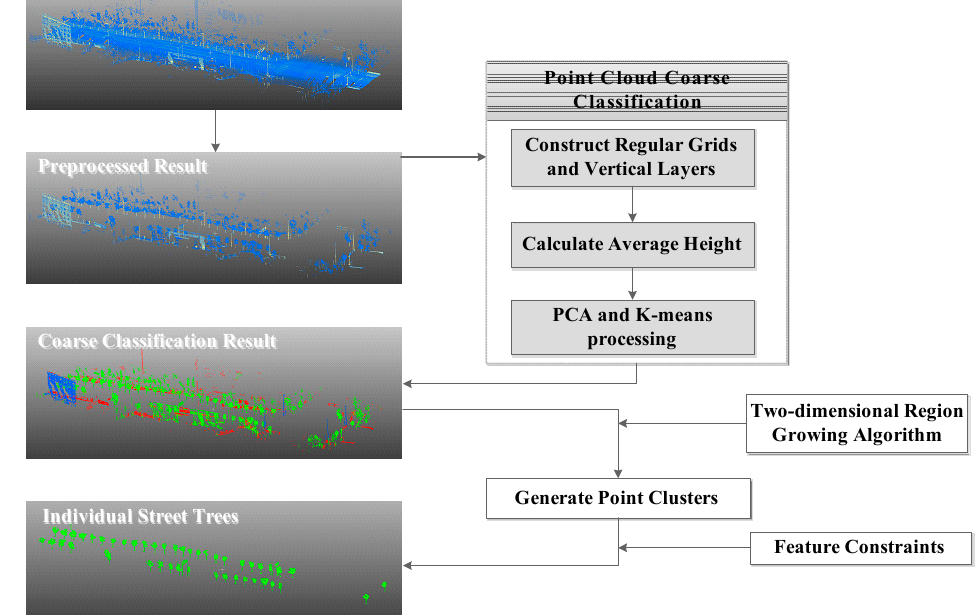
Figure 4. The process of extracting individual street trees.